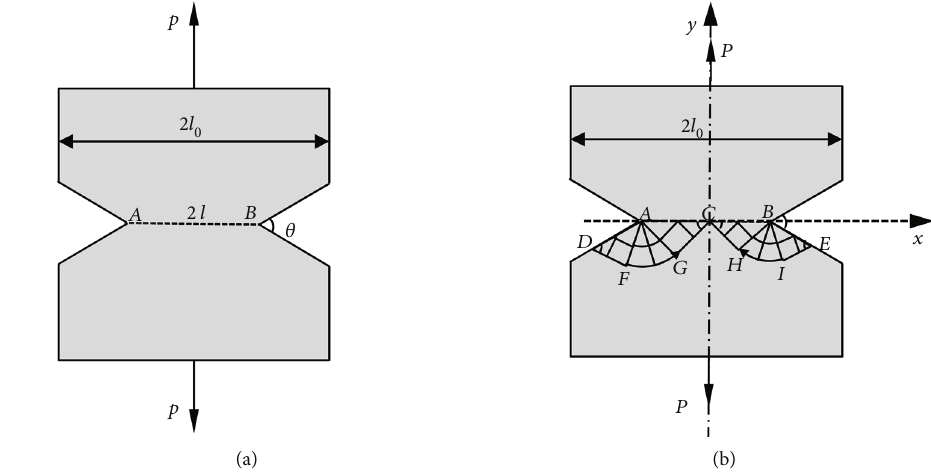
Figure 7: Diagram of (a) plane lath with V-notch tension; (b) slip-line fi